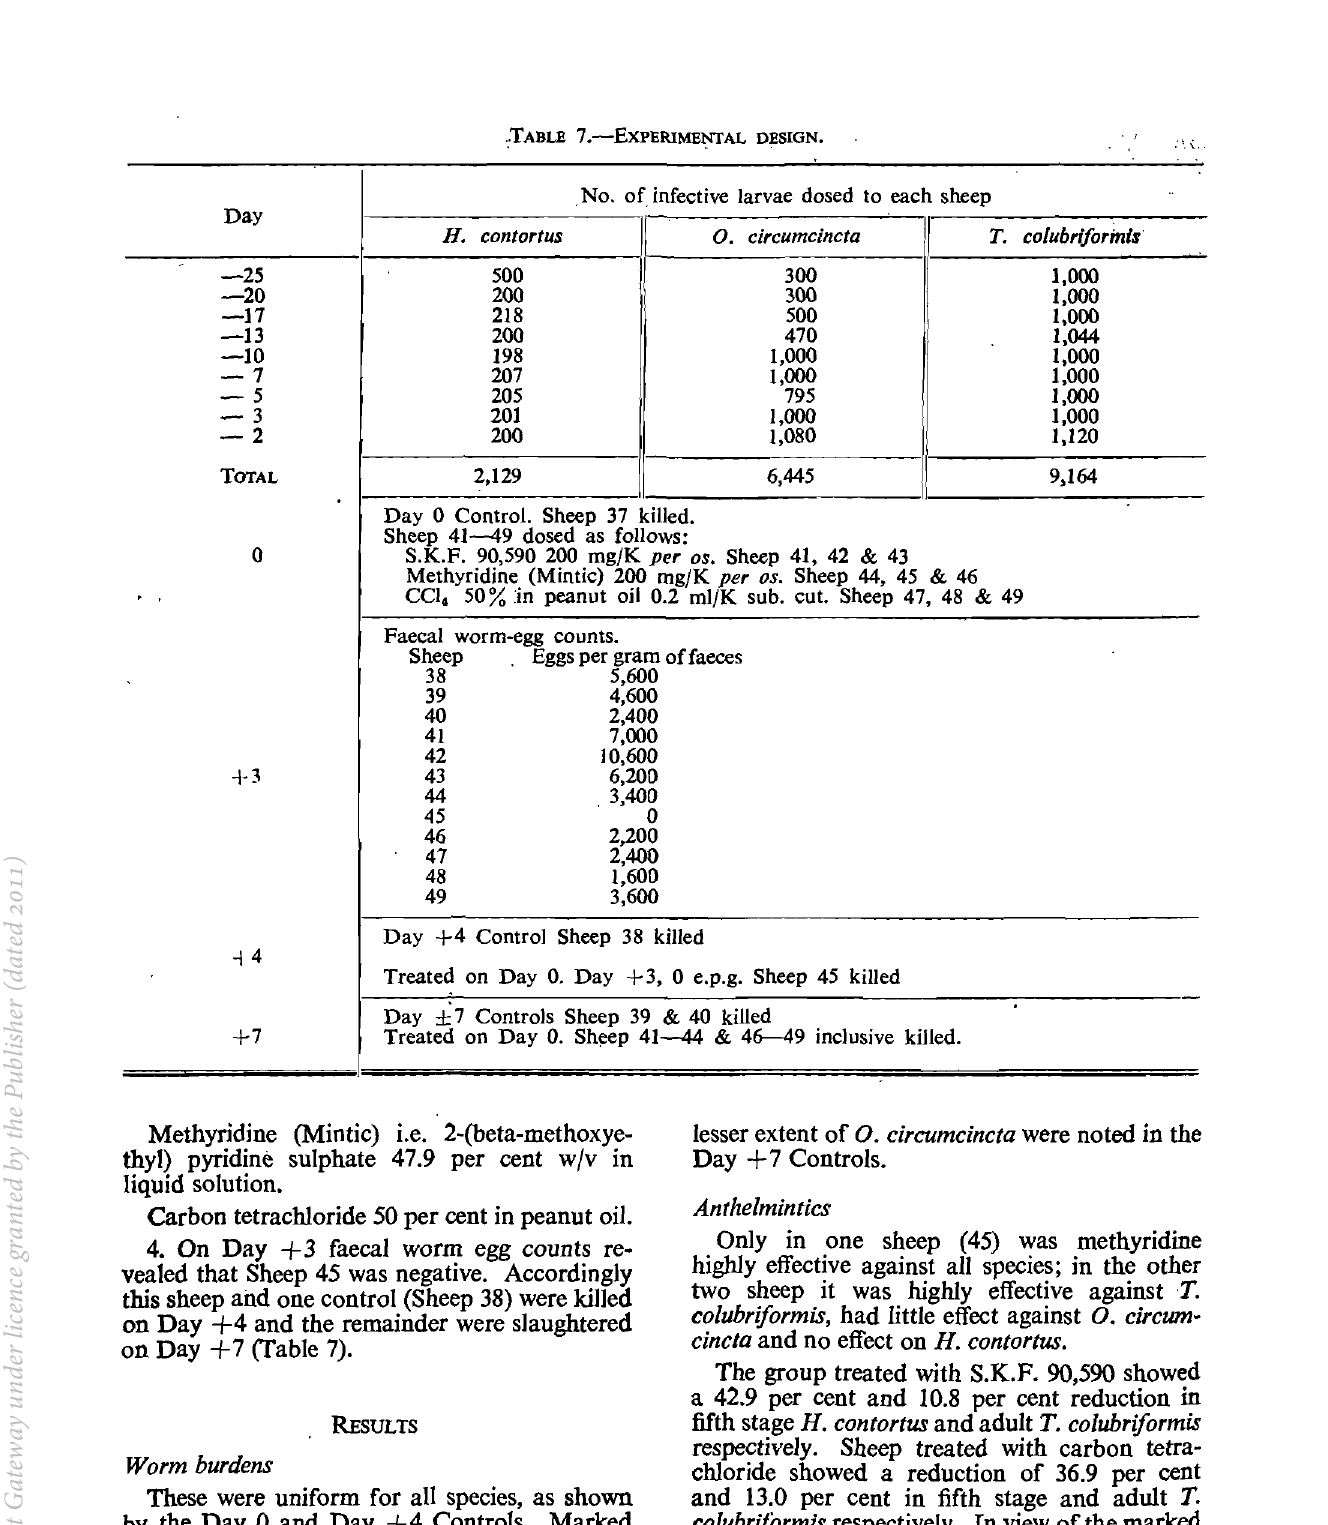
·TABLE 7.-EXPERIMEl'rrAL DESIGN •